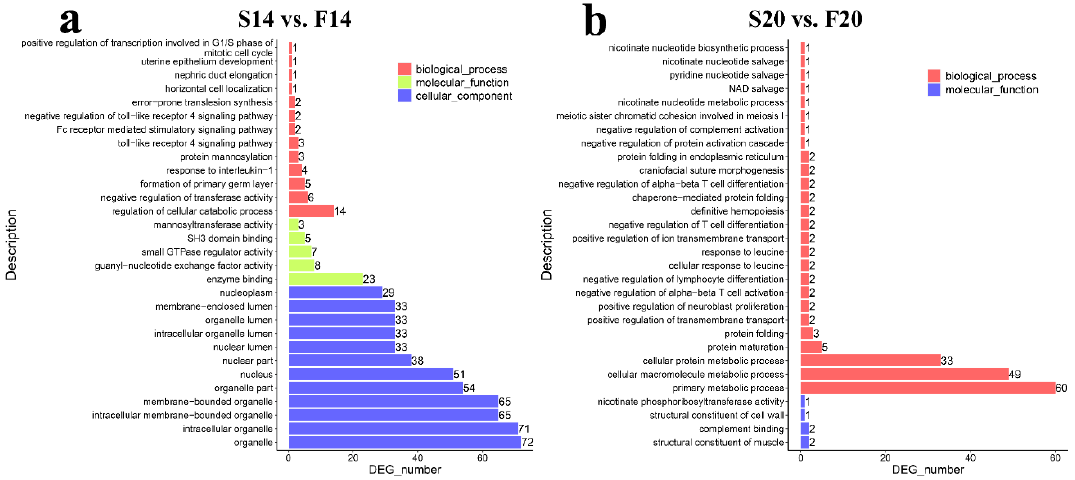
Figure 3. GO enrichment analysis of the host genes of the differentially expressed circRNAs. ( a ) Results of GO analysis for S14 vs. F14. ( b ) Results of GO analysis for S20 vs. F20.